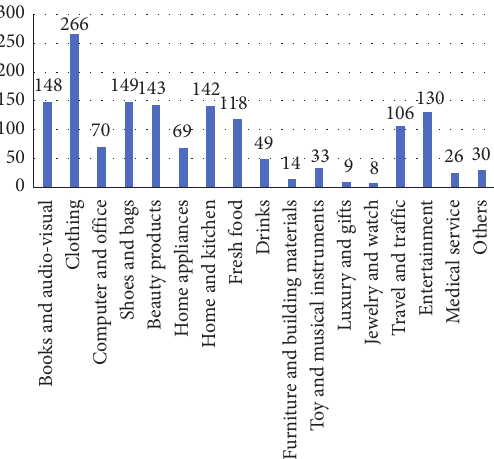
Figure 4: The main categories of consumption in mobile shopping.